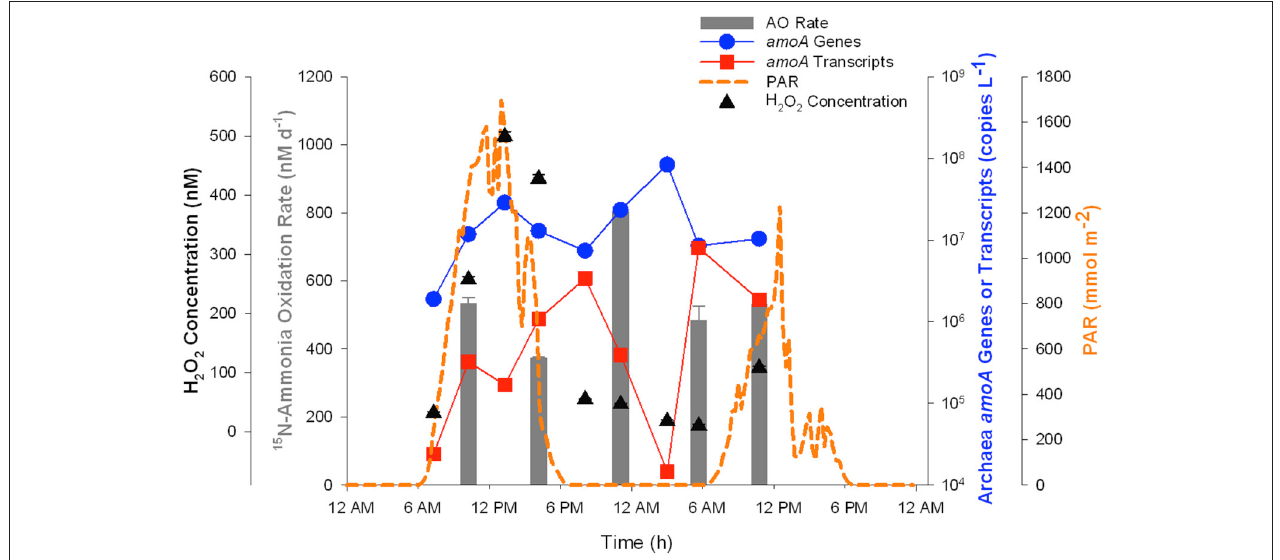
FIGURE 7 | Diurnal measurements of Thaumarchaeota over 24h at Marsh Landing in September 2013. Thaumarchaeota amoA genes (blue circles) and transcripts (red squares) are shown along with ammonia oxidation rates (gray bars). Photosynthetically active radiation (PAR) is also plotted (orange dashed line) for reference (data from Sapelo Island National Estuarine Research Reserve; http://cdmo.baruch.sc.edu/) with H 2 O 2 concentrations (black triangles). Error bars represent standard deviation from the mean of [H 2 O 2 ] measurements ( n =